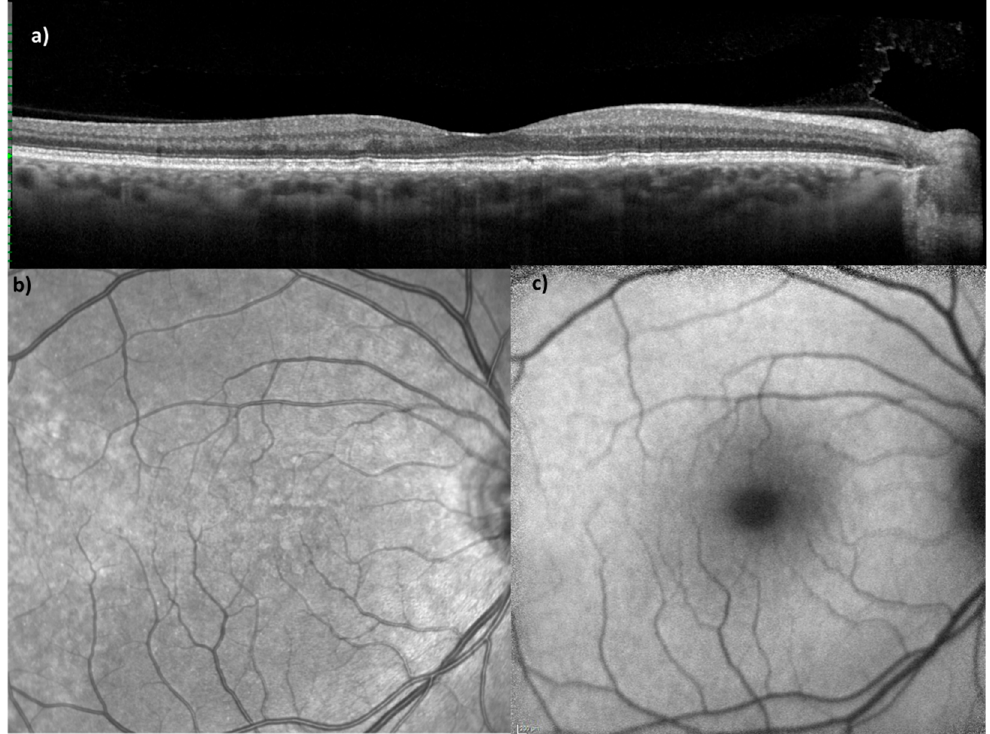
Figure 1. Multimodal imaging of a SLE patient with drusen-like deposits. ( a ) Illustrates an optical coherence tomography scan, ( b ) a near-infrared (NIR) image, and ( c ) a fundus autofluorescence im- age.